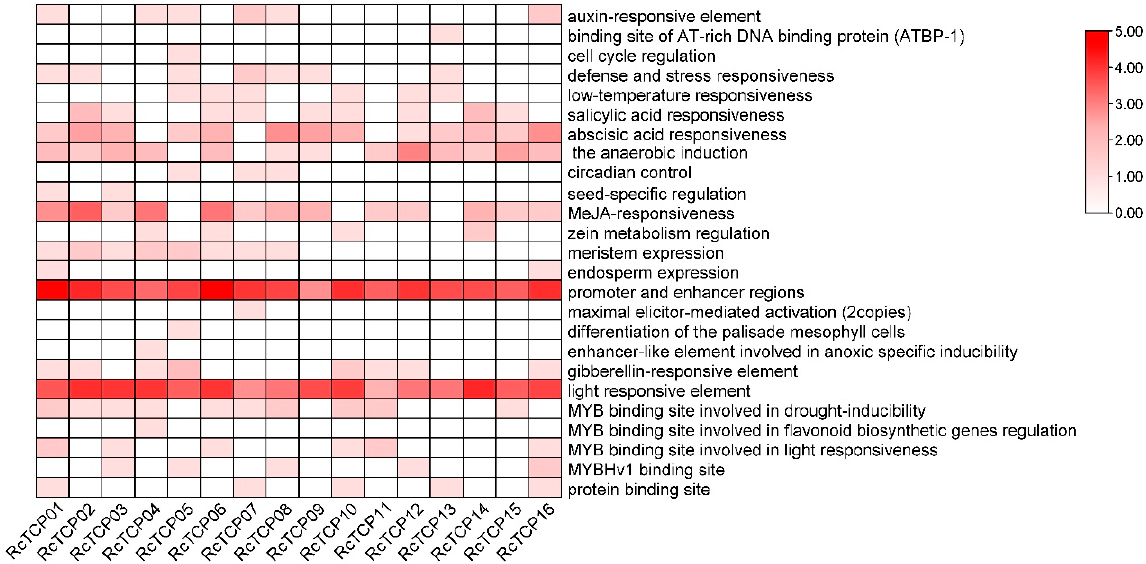
Figure 4. The cis -acting elements in the promoters of RcTCP genes. PlantCARE predicted cis -regulatory elements (CRES) in the RcTCP gene promoter region (upstream 2000 bp). The heatmap represent the abundance of the copy number of cis -regulatory elements.